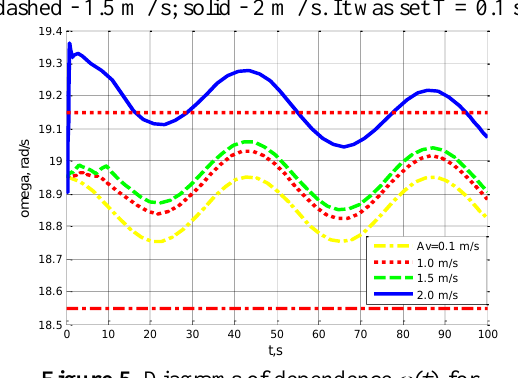
Figure 5. Diagrams of dependence ( ) t  for several values of the amplitudes of the wind oscillations A . V